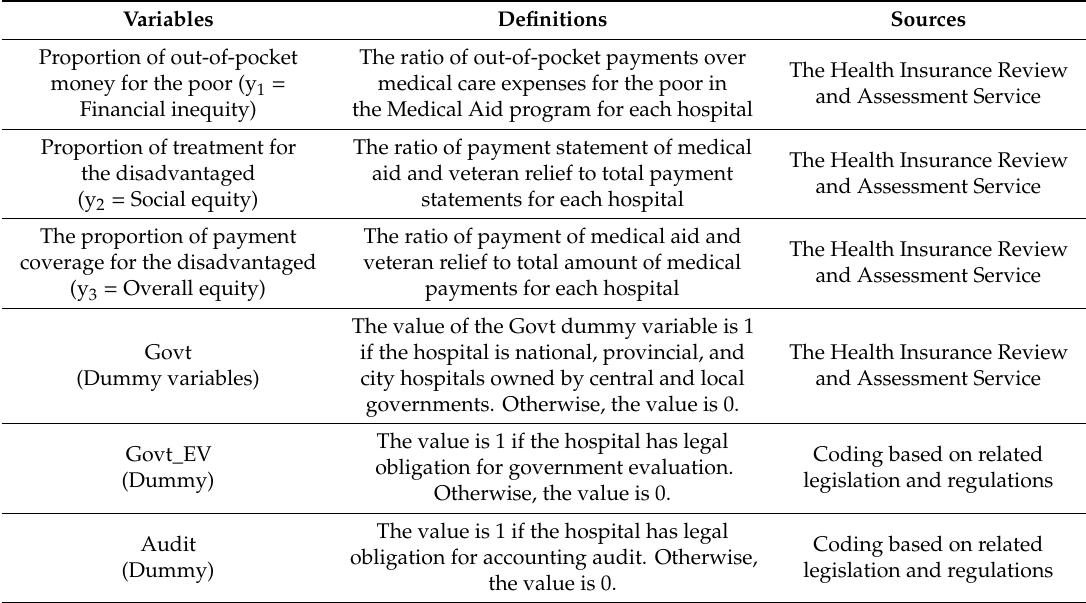
Table A1. Definitions of variables and data